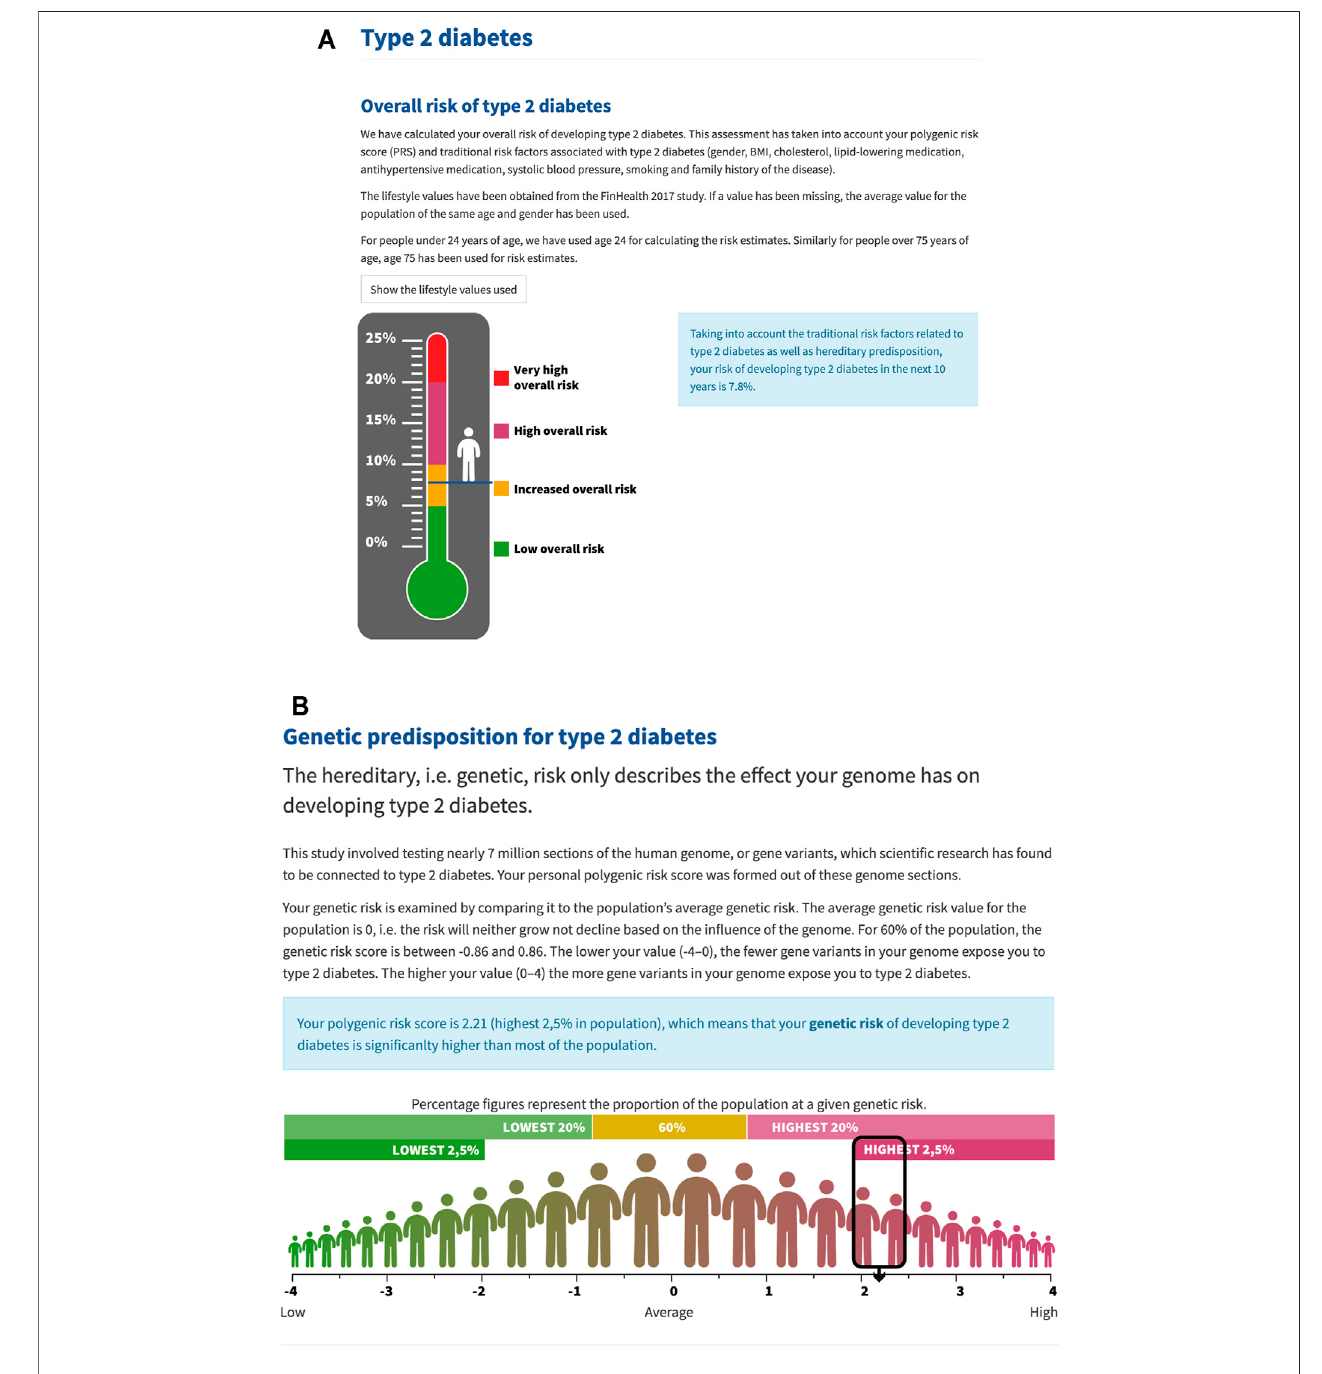
FIGURE 1 | Layout of the portal. (A) The absolute (overall) risk was presented as a thermometer. The risk limits for T2D were 0 – 5% (low), 5 – 10% (increased), 10 – 20% (high), > 20% (very high). (B) PRS was presented as a single value in relation to the whole population on a normal distribution curve.